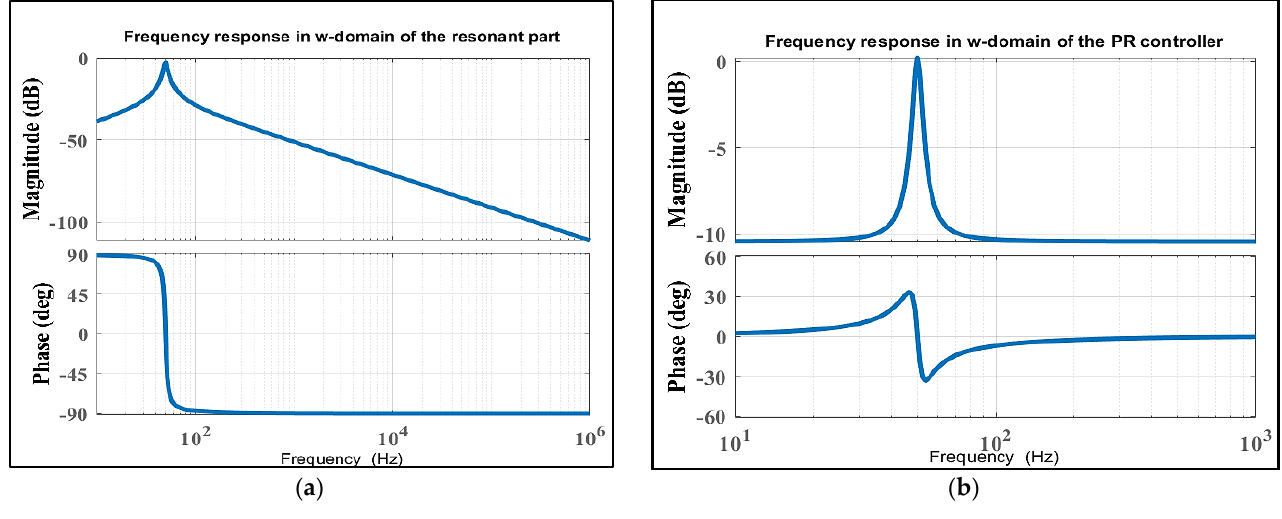
Figure 6. The magnitude and phase response of the adopted ( a ) resonance filter and ( b ) PR controller.